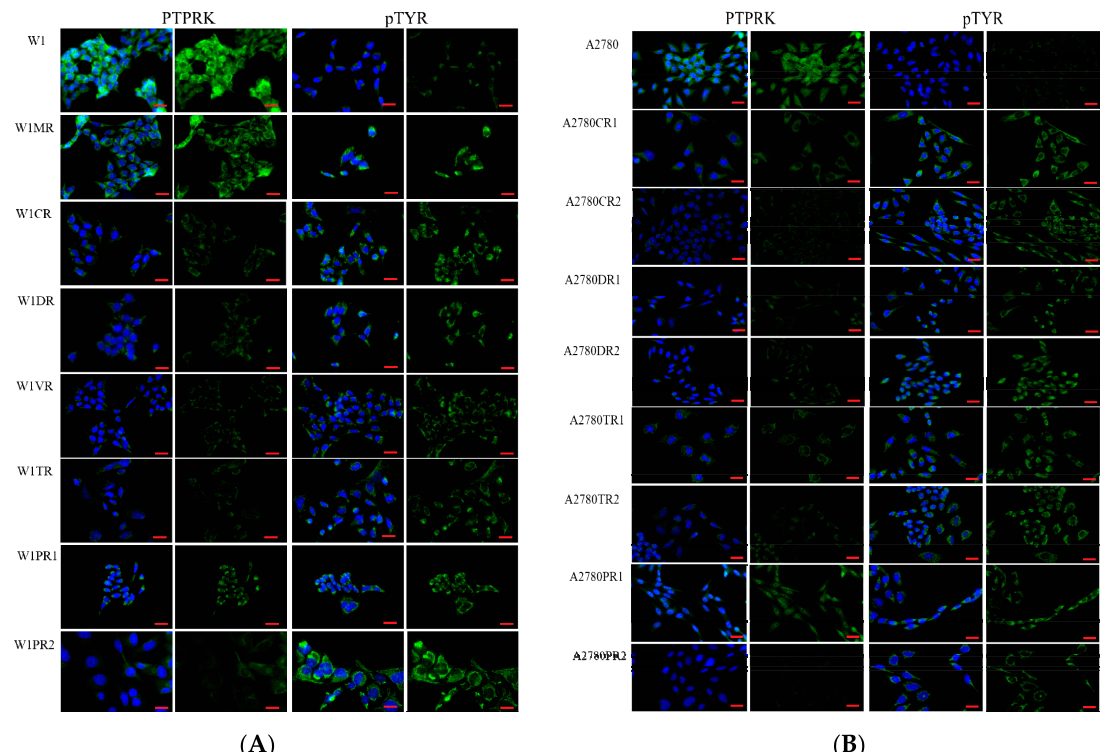
Figure 2. Immunofluorescence visualization of PTPRK and pTyr expression in the W1 and drug resistant cell lines ( A ) and in A2780 and drug resistant cell lines ( B ). PTPRK was detected using the anti-PTPRK antibody and an Alexa Fluor ® 488-conjugated secondary antibody (green). pTyr was detected using the anti-pTyr antibody and MFP488-conjugated secondary antibody (green). Cell nuclei were stained with DAPI (blue). Scale bar = 20 µm.